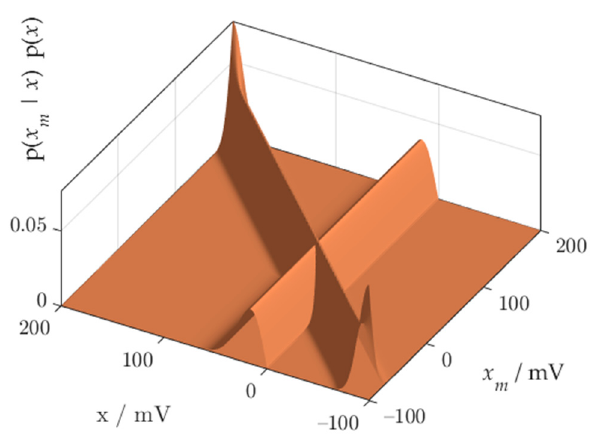
Figure 7. Calculation of the joint pdf using the extended domains of measurand and measurement values.